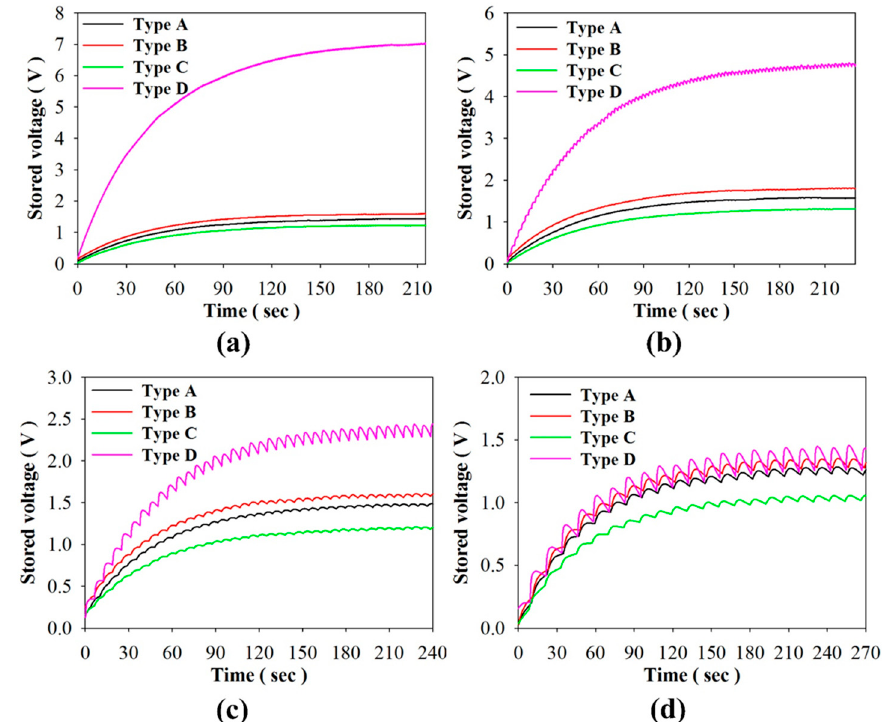
Figure 13. Relationship between the stored voltage and time when using the PZT cells with various structures (Types A to D) and periods of about ( a ) 1 s; ( b ) 4 s; ( c ) 12 s; and ( d ) 24 s.